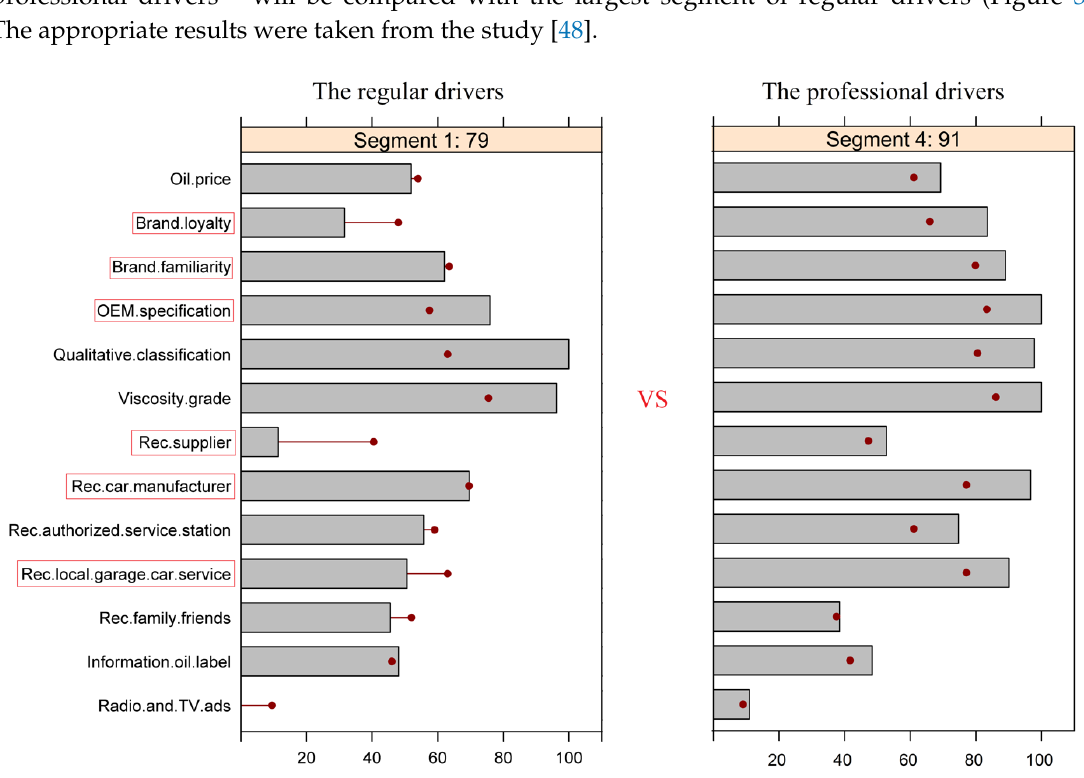
Figure 3. Comparison of the largest segments of regular drivers and professional drivers.